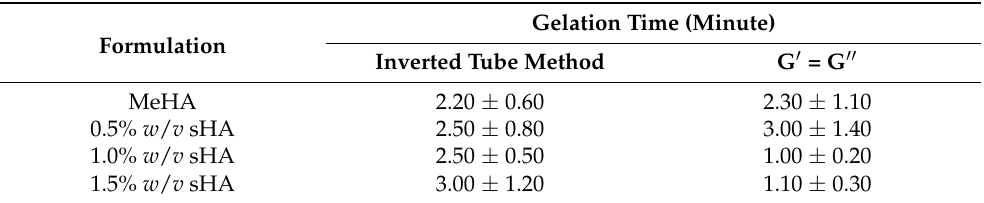
Table 2. The gelation time of four types of hydrogel formulations, detected by inverted tube method and by rheology profile where G (cid:48) = G (cid:48)(cid:48) .